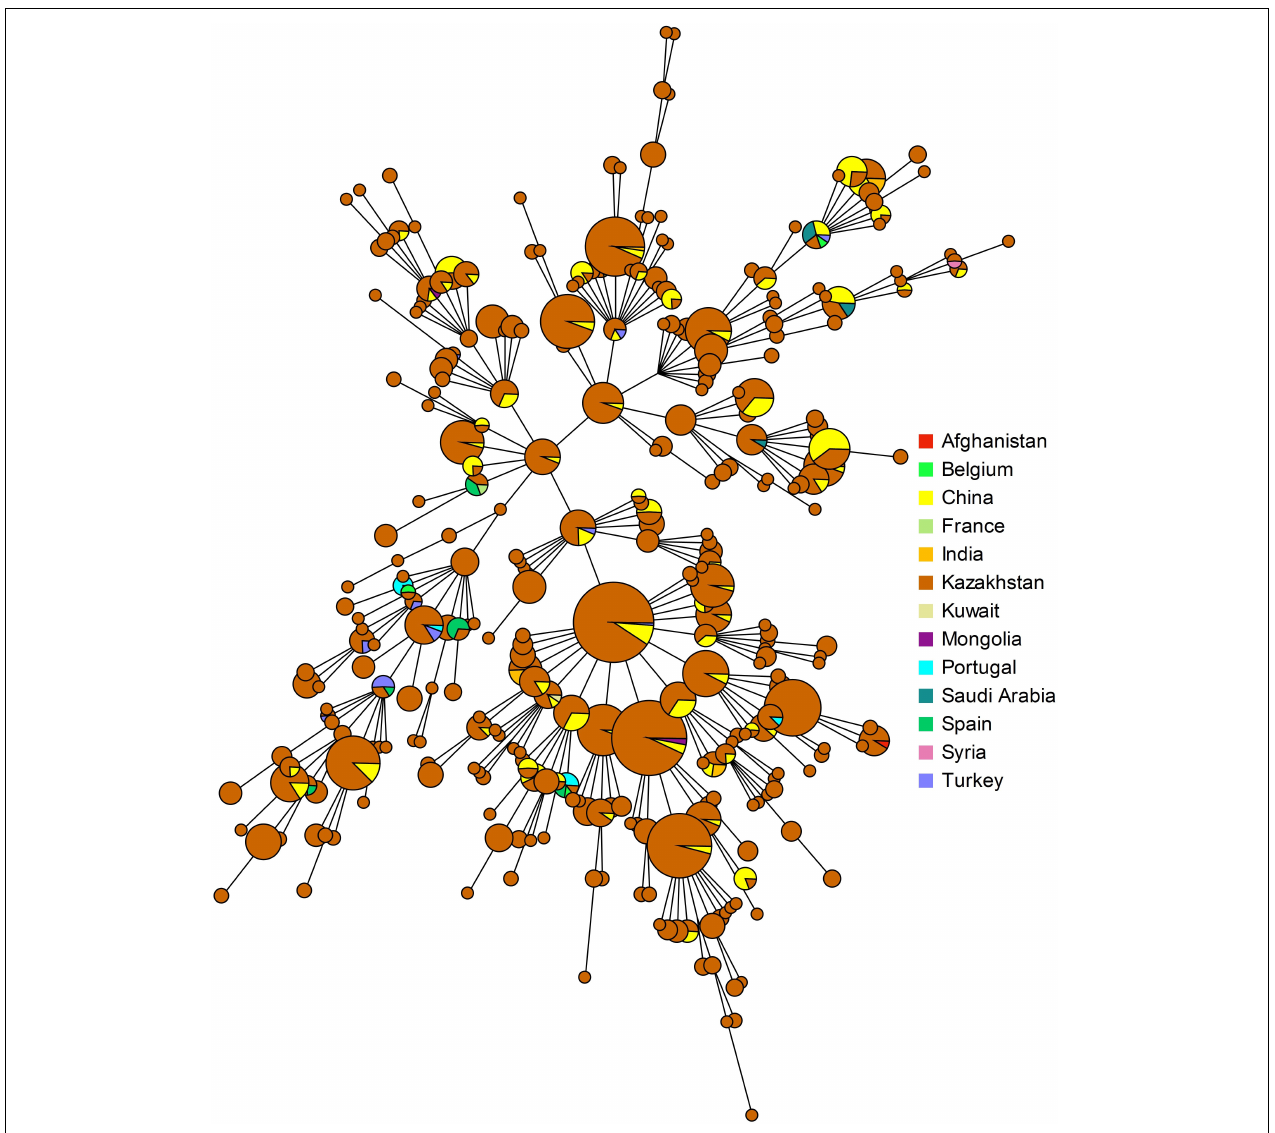
FIGURE 6 | Geographic origin of strains present in MLVAbank Brucella_4_3 and showing an MLVA16 genotype present in